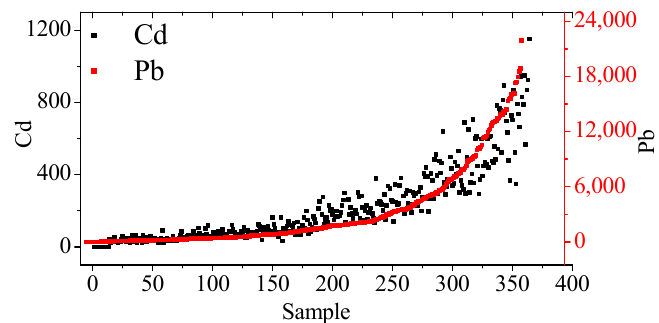
Figure 5. Sorted samples according to Pb spectral intensity.